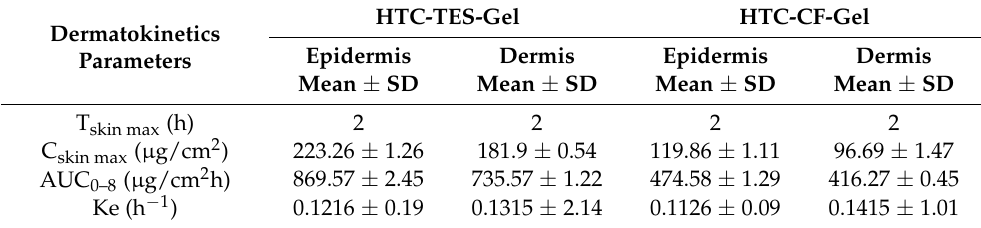
Curve, Ke = Elimination Rate Constant.